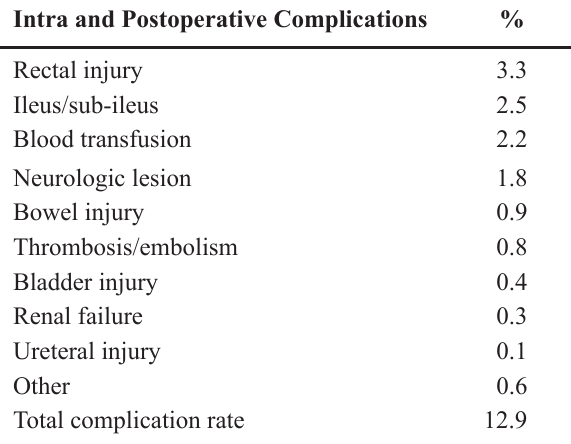
Table 5 – Main intra and postoperative complications of laparoscopic radical prostatectomy in late series (Lein et al., ref. 32).